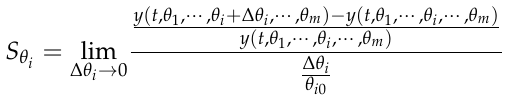
Table 2. Results of the algorithm test.